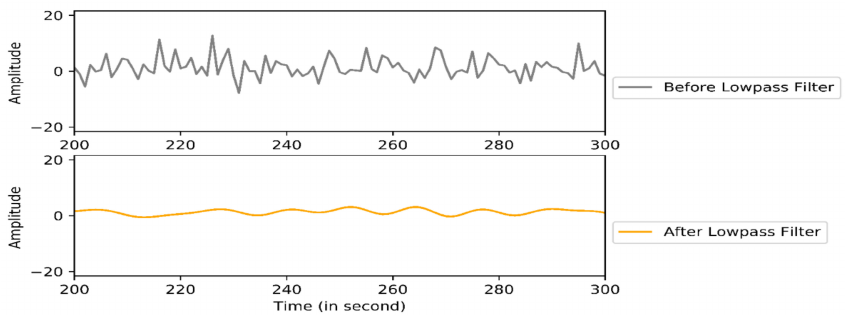
Figure 2. Generating smooth signal from accelerometer sensor data (upper) using a Butterworth low pass filter (lower).